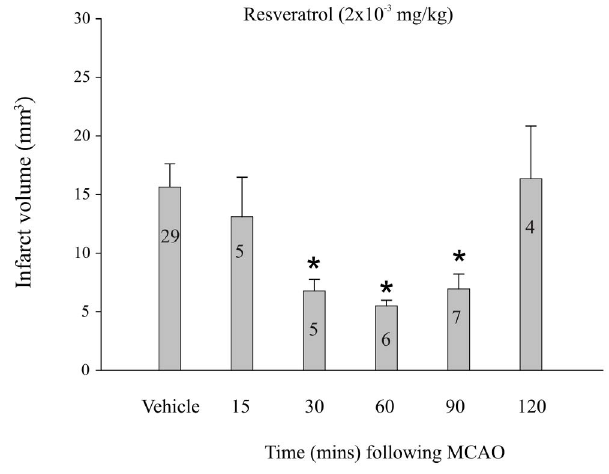
Figure 2. Time course of resveratrol-induced neuroprotection. Bar graph summarizing the effect of resveratrol injected 15 minutes into middle cerebral artery occlusion (15), or at 30 min intervals post- reperfusion. Each bar represents the mean 6 S.E.M. (n=5–6/group) and * indicates significance ( p # 0.05) from the pooled vehicle-treated (propylene glycol 4 6 10 2 3% (v/v)) control group.